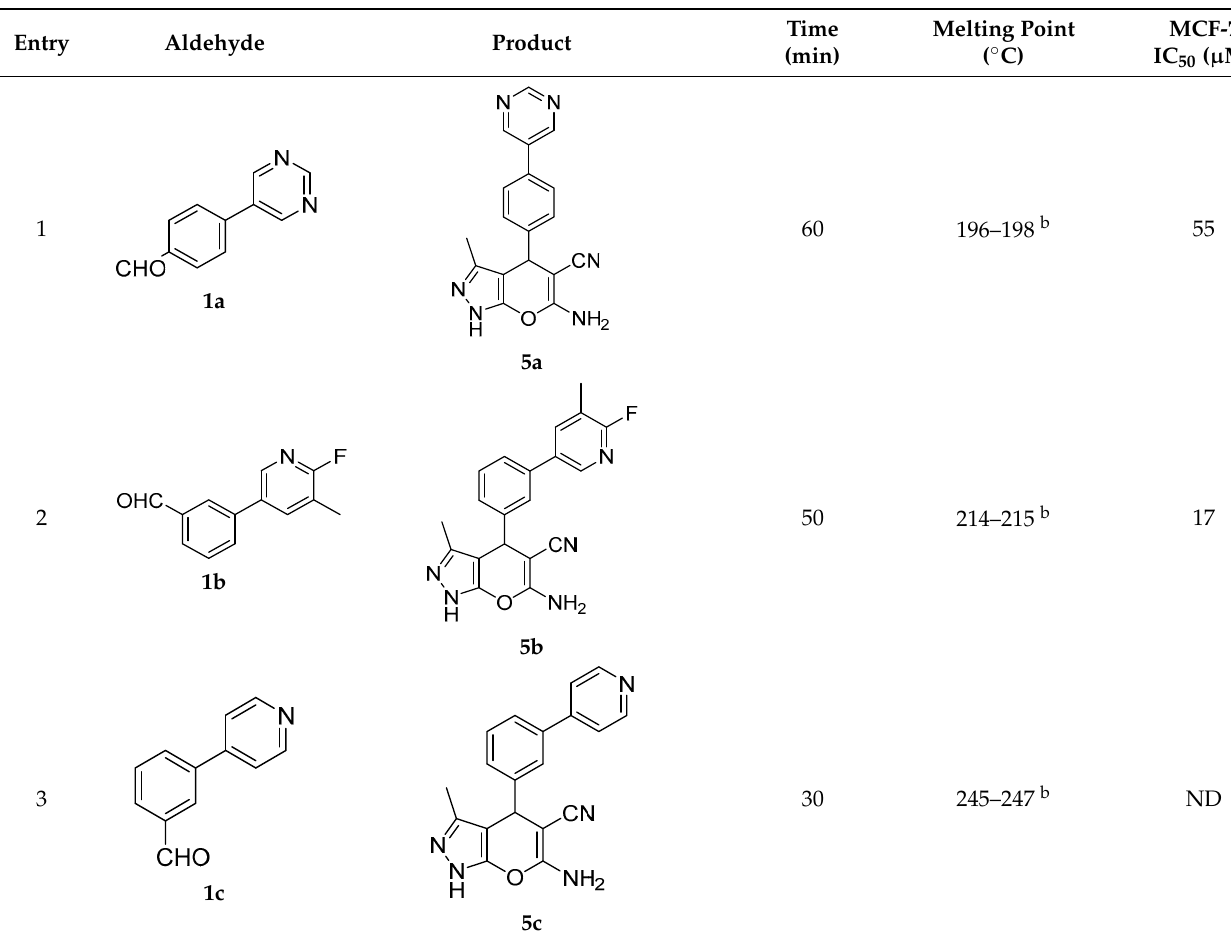
Table 2. Physical data and cytotoxicity data of 6-amino-4-aryl-3-methyl-1,4-dihhydropyrano [2,3- c ] pyrazole-5-carbonitriles.